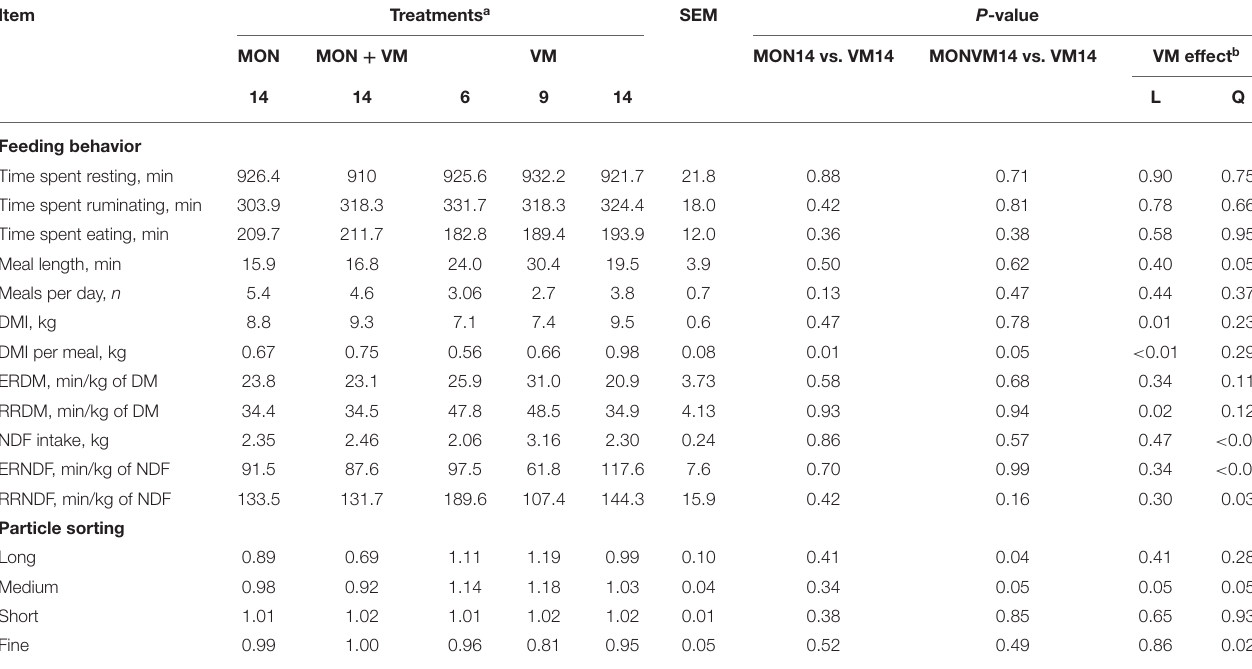
TABLE 3 | Feeding behavior and particle sorting of Nellore yearling bulls consuming high-concentrate diets containing sodium monensin (MON), virginiamycin (VM), or both right after the end of the adaptation period (day 7, 10, or 15). Item Treatments a SEM P